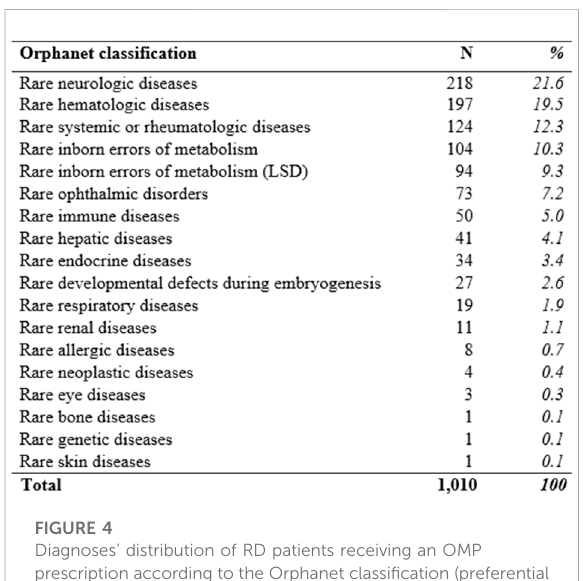
FIGURE 4 Diagnoses ’ distribution of RD patients receiving an OMP prescription according to the Orphanet classi fi cation (preferential parent). LSD (Lysosomal storage